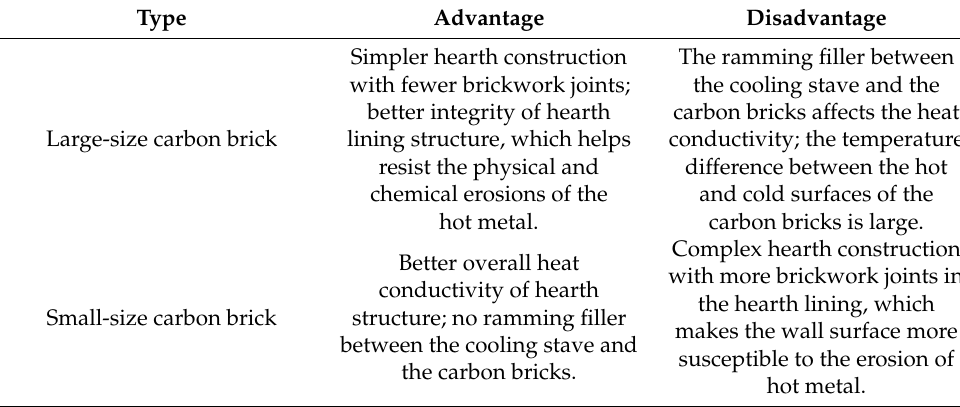
Table 7. Features of the hearth refractory structures using the large-size and small-size carbon bricks